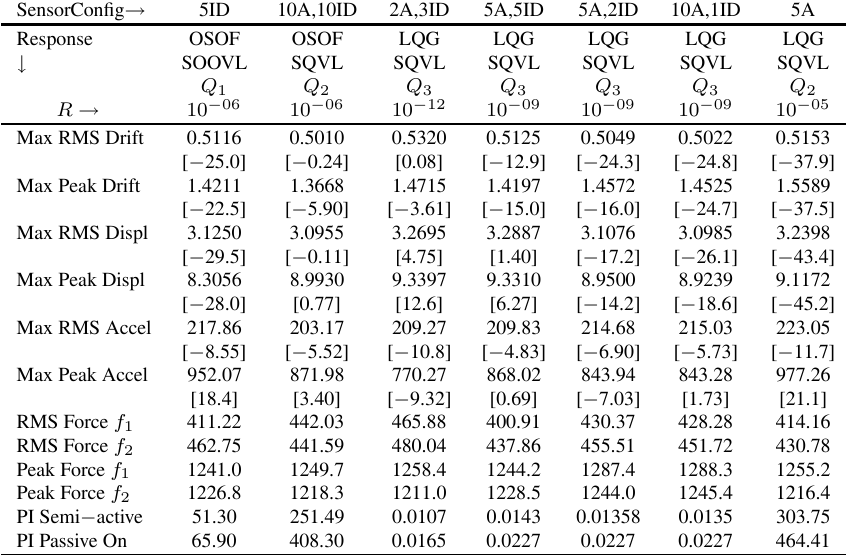
Maximum peak/RMS response for various sensor con fi gurations, two dampers, (Drift/Displ - cm, Accel - cm/s 2 , force -